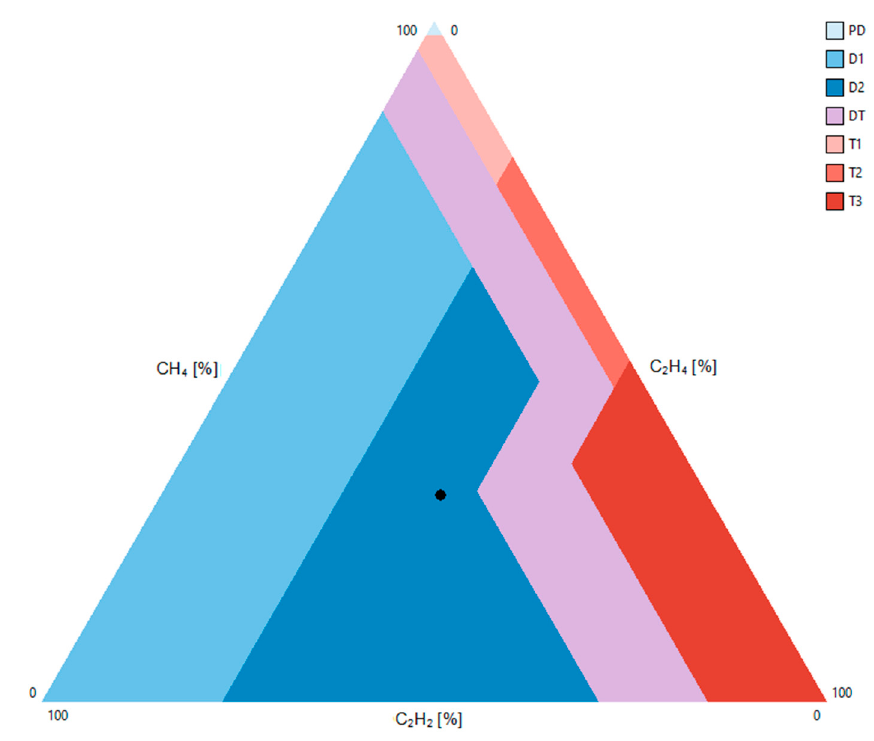
Figure 3. The result of the analysis using the basic form of Duval’s triangle.